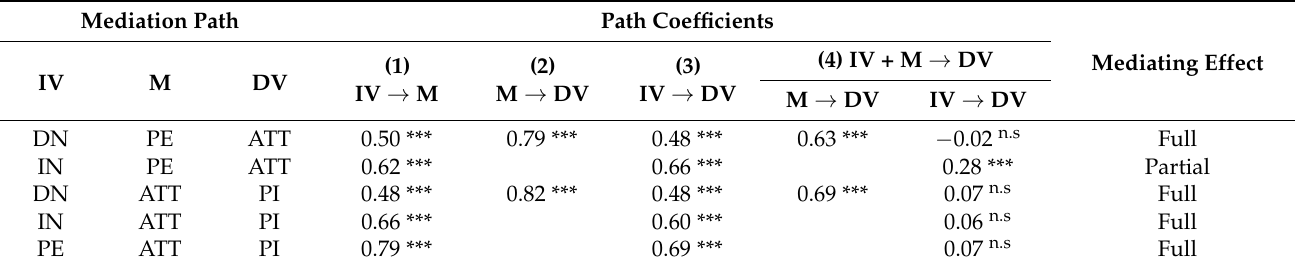
Table 4. Mediating effect test (Baron and Kenny’s (1986)